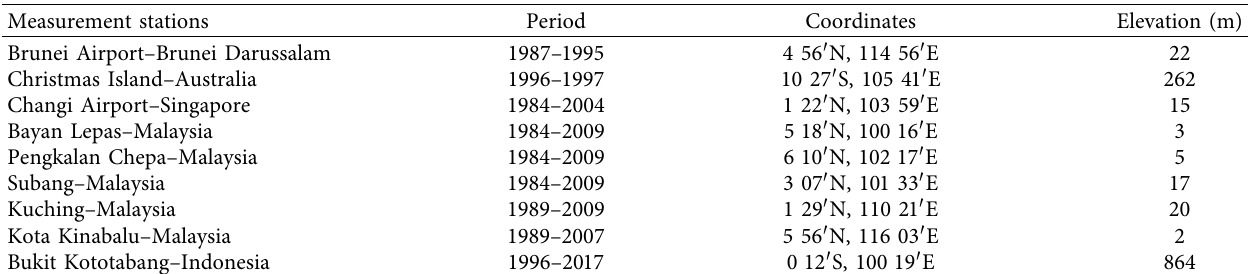
Table 2: Summary of the WRDC station network used for